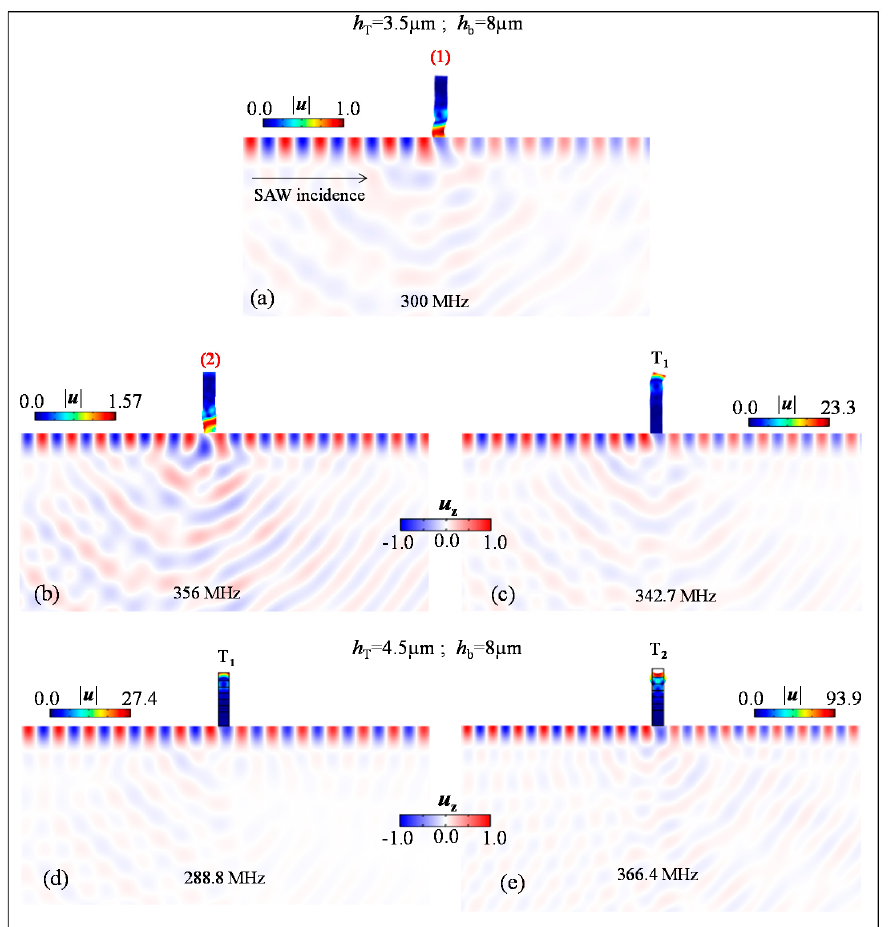
Figure 9. Total displacement field in the ridge as well as the (cid:1873) (cid:3053) component in the Si substrate at the frequencies indicated by a red arrows ( a ), ( b ) and T 1 ( c ) in Figure 8a for the case of h T = 3.5 µm. The lower panel is for the case h T = 4.5 µm at the frequencies of the peaks T 1 ( d ) and T 2 ( e ) in Figure 8b.